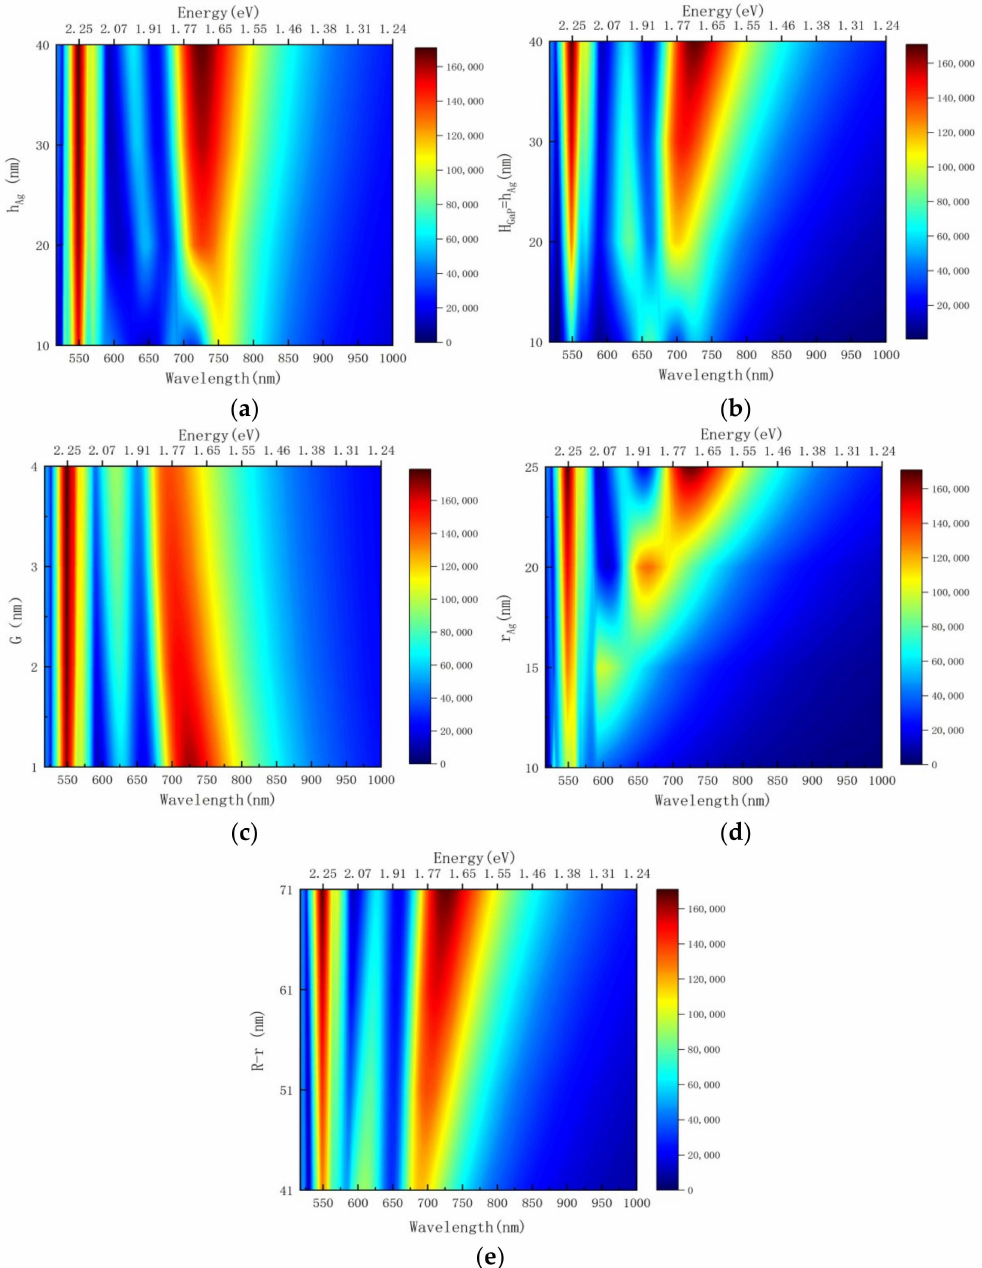
Figure 4. ( a ) Scattering cross-sections for different internal silver disk heights; ( b ) scattering cross- sections for different inner and outer heights; ( c ) scattering cross-sections for different distances between the heptamer of silver and the GaP nanoring; ( d ) comparison of the scattering areas for silver disks of different radii; ( e ) the influence of the width of the GaP nanoring on scattering